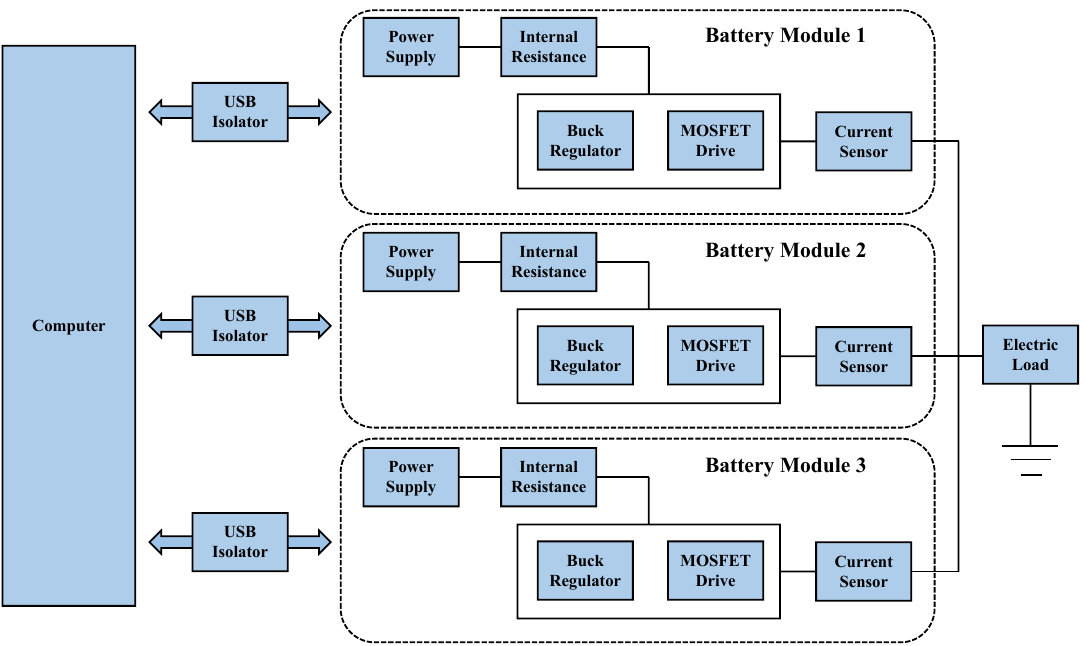
Figure 8. Schematic of the experimental battery